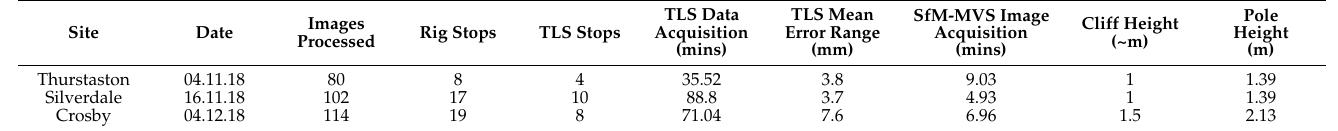
Table 1. Data acquisition information for TLS and camera rig SfM-MVS surveys at Thurstaston, Silverdale and Crosby. Date given as